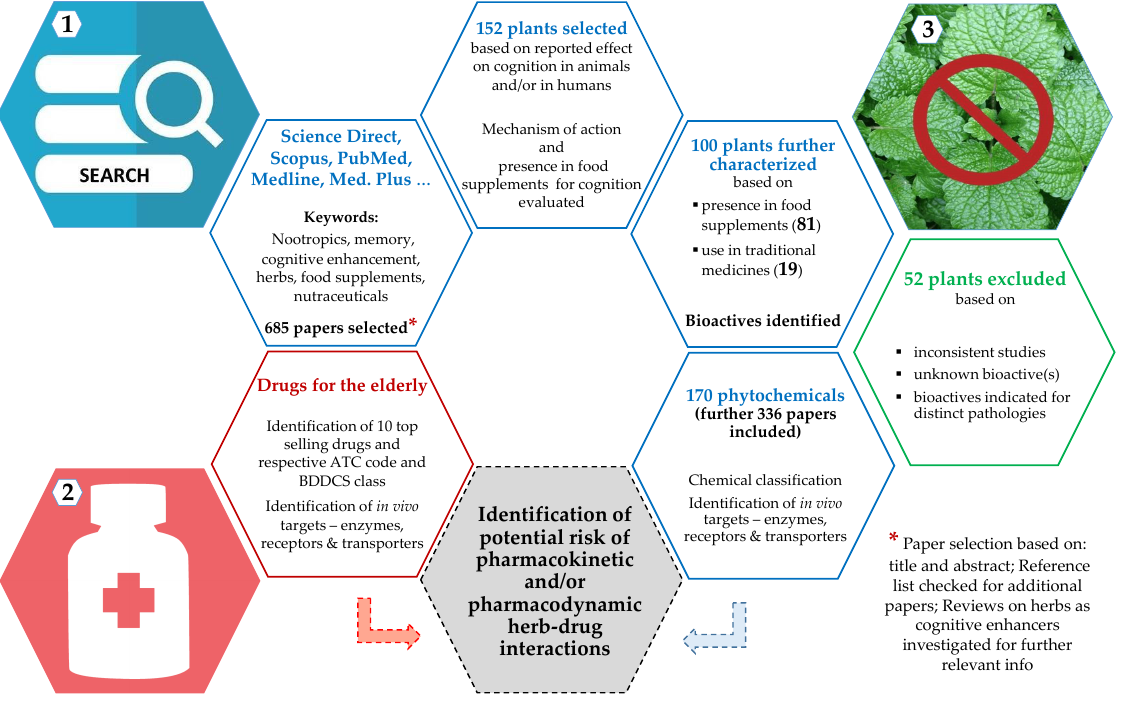
Figure 1. Workflow used to retrieve information to identify potential risk of HDI in aged food supplements’ consumers. Herbals are represented in blue ( 1 ), drugs in red ( 2 ), and exclusions in green ( 3 ). The number of publications used, botanicals characterized, and bioactives identified and studied, is highlighted in